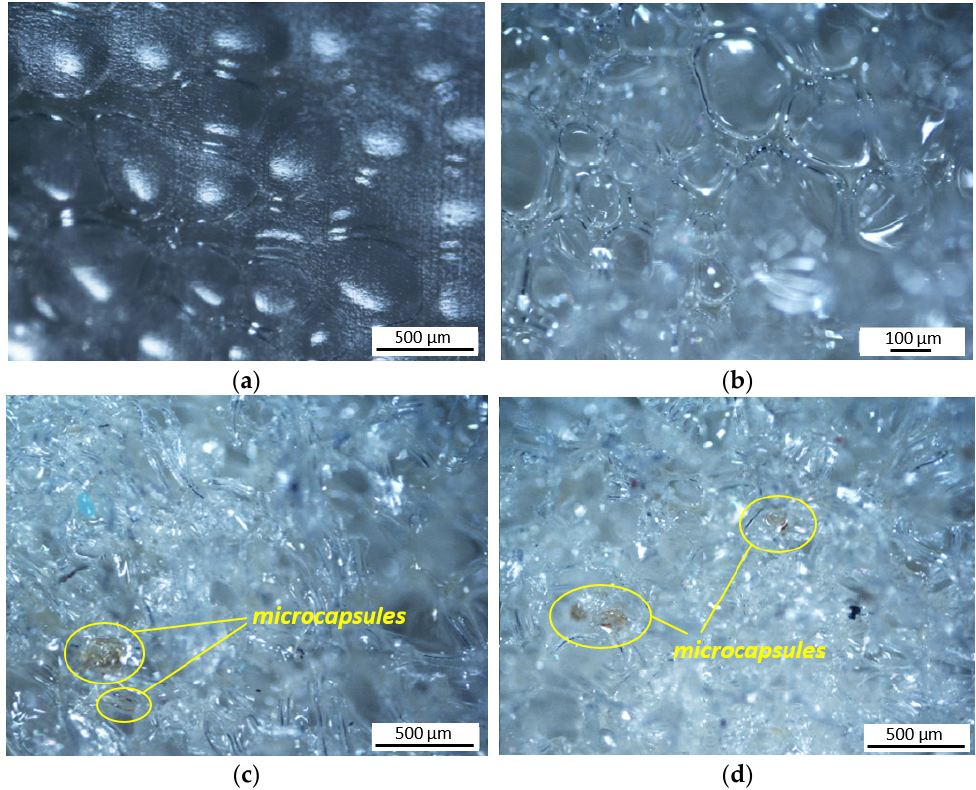
Figure 6. ( a , b ) optical microscopy images of PU foam without microcapsules; ( c , d ) images of SH capsules within the PU foam.